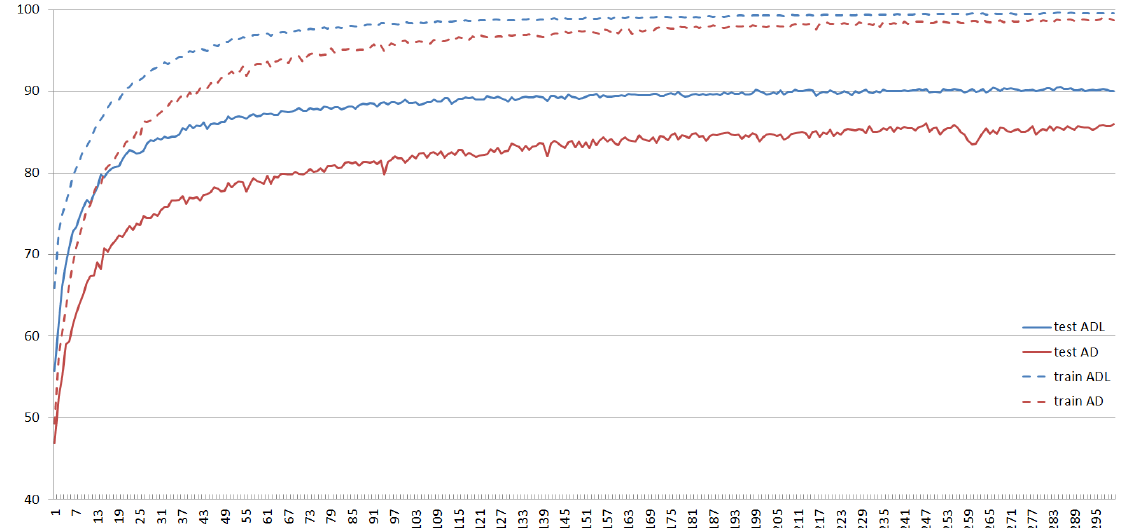
Figure 1. The precision change of two different models. The two red curves show training and test accuracy of the model AD-CNN change with the number of iterations varying. Likewise, the two blue curves indicate two precisions of the model in this paper vary with the number of iterations changing.